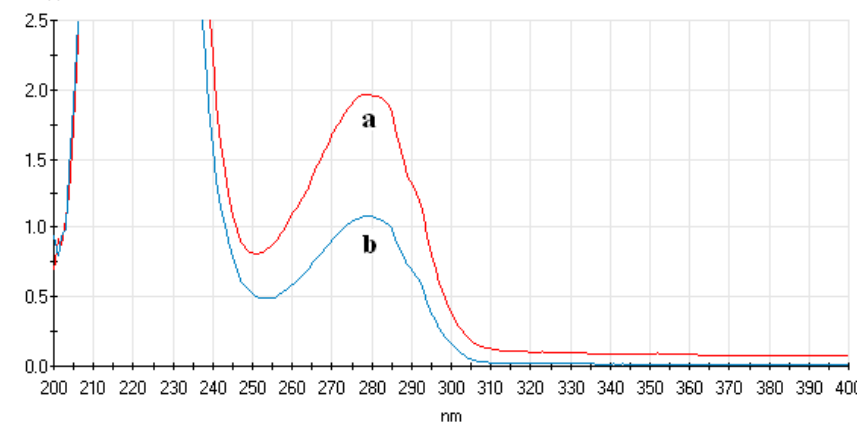
Figure 4. UV-Vis spectrum of SPA solution before and after binding to gold-magnetic nanoparticles. ( a ): UV-Vis spectrum of 320 µg of SPA solution before binding to gold-magnetic nanoparticles; ( b) : UV-Vis spectrum of 320 µg of SPA solution after binding to gold-magnetic nanoparticles).